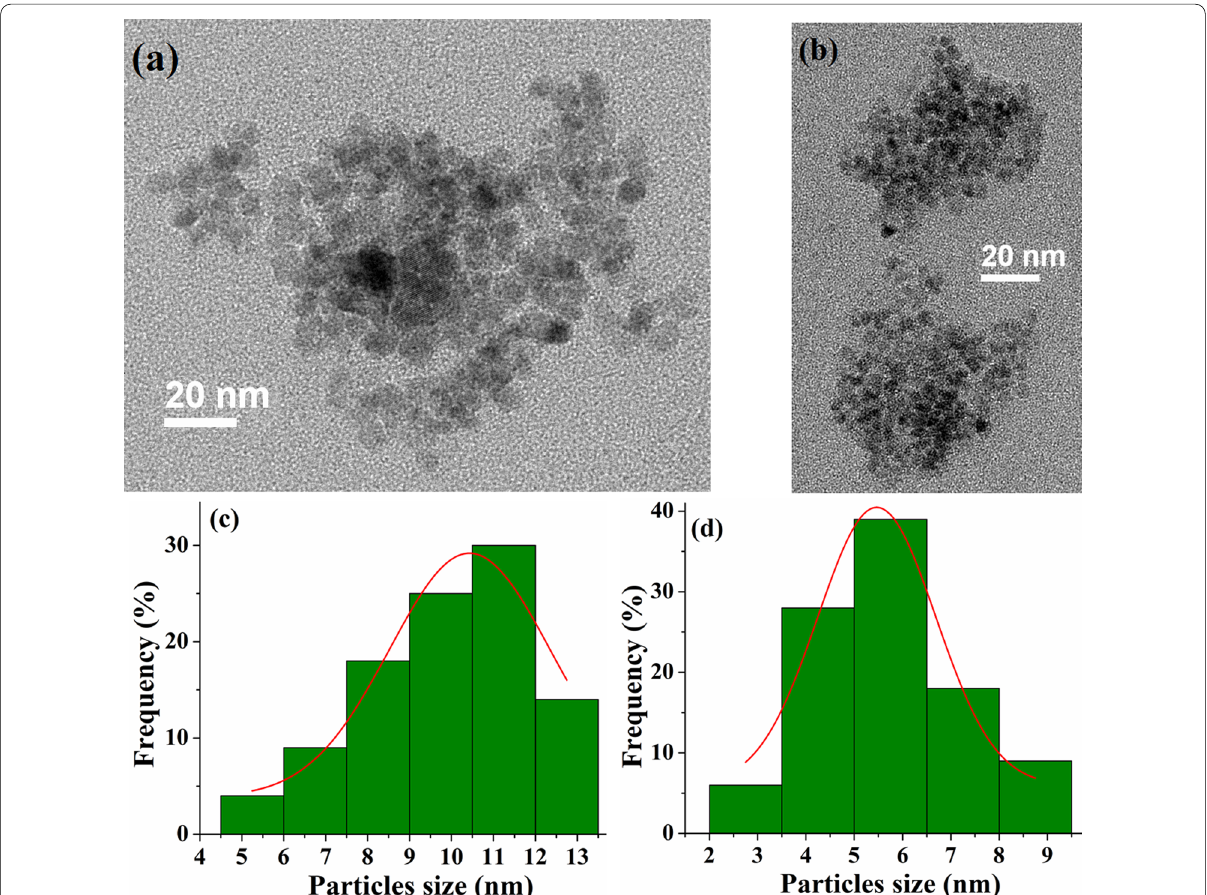
Fig. 2 TEM micrographs of the samples and the histograms of the particle size distribution: ( a ), ( c ) for FeMn 2 O 4 nanoparticles; ( b ), ( d ) for FeCo 1.8 O 4